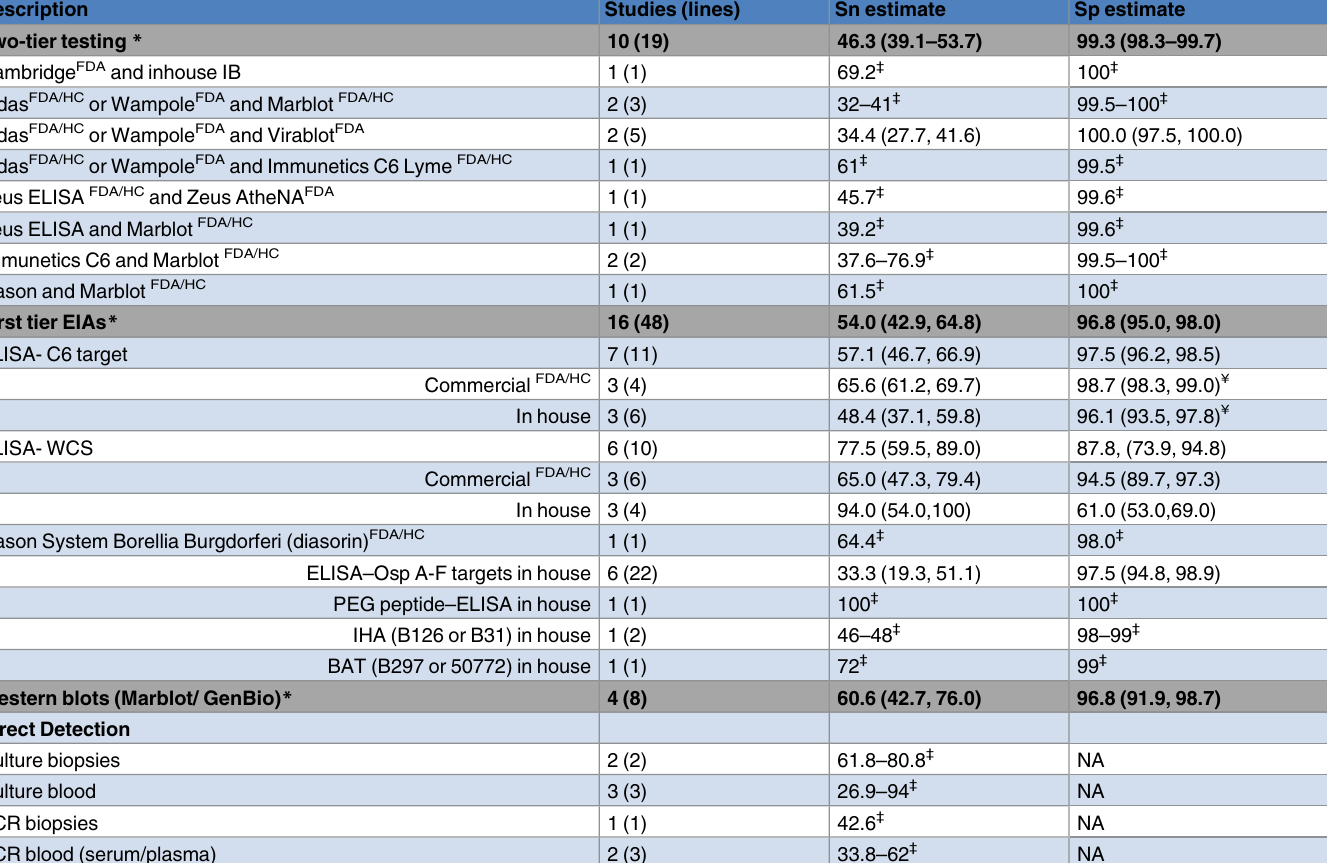
Table 8. Summaryof the sensitivity and specificity of different testing options for early Lyme disease (stage 1)